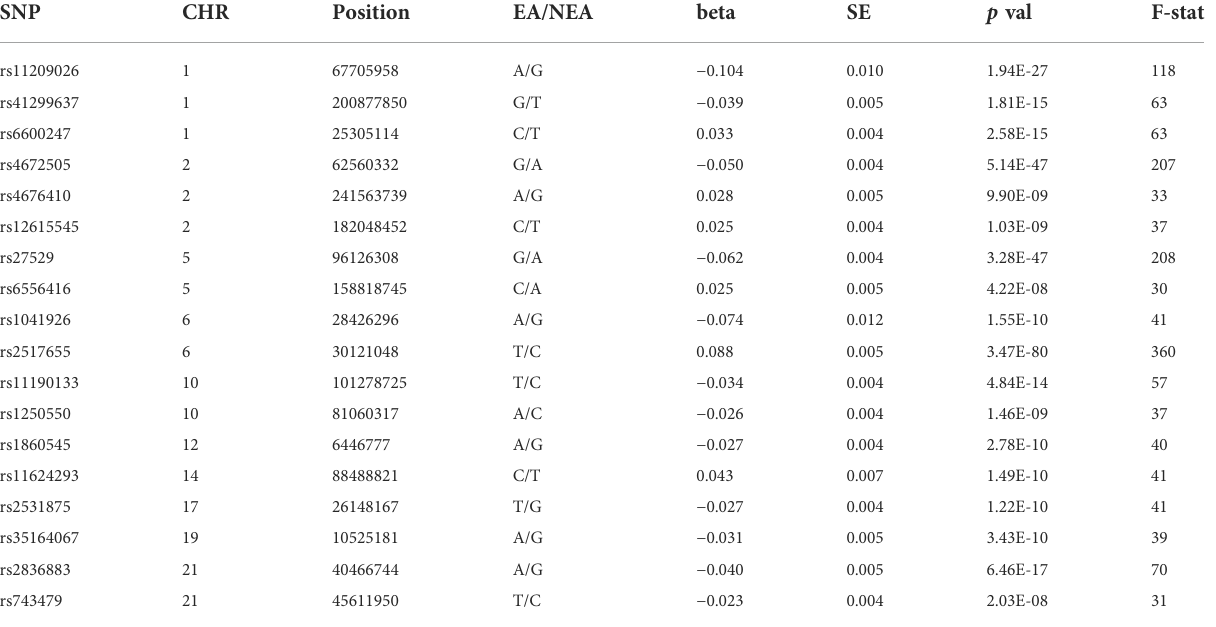
TABLE 2 The information of 18 IV SNPs in MR analysis.